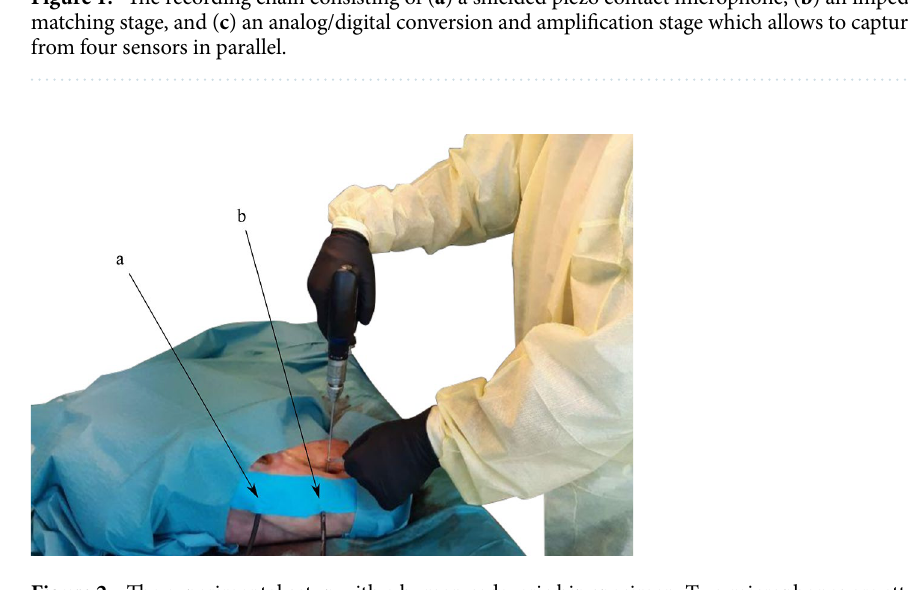
Figure 2. The experimental setup with a human cadaveric hip specimen. Two microphones are attached to the specimen’s skin surface with kinesiology tape to permit synchronously recording in parallel. The contact sensors are placed ( a ) at the trochanter major and ( b ) next to the incision, in diaphysis